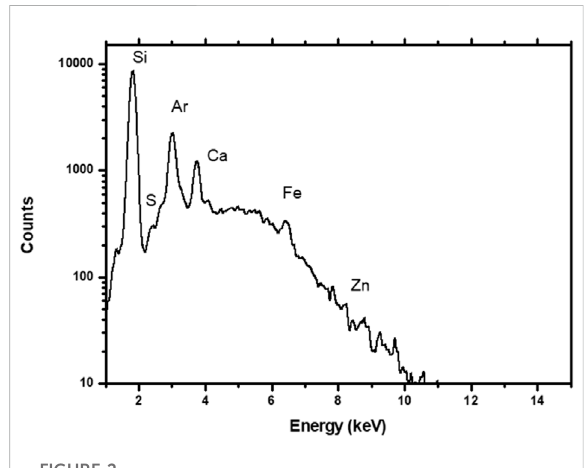
FIGURE 2 PIXE (Particle Induced X-Ray Emission) spectrum of